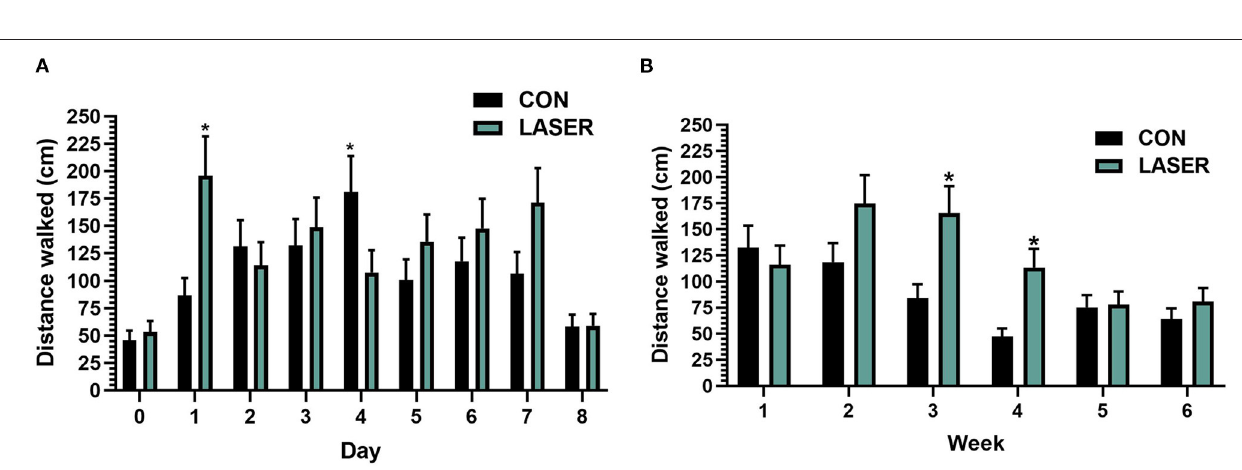
Frontiers in Animal Science |